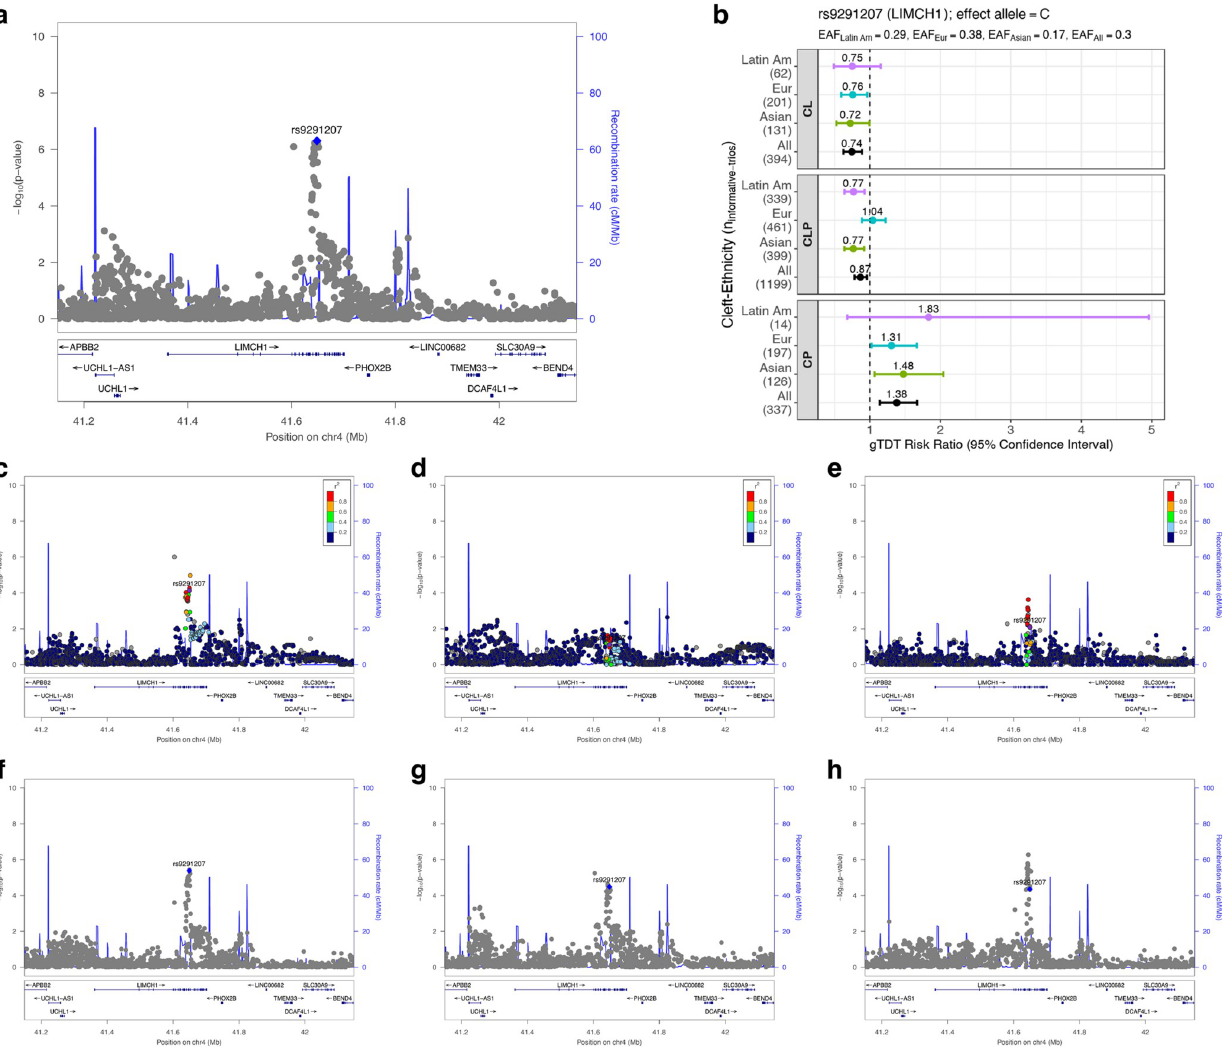
Fig 3. Regional association plots for 4p13 ( LIMCH1 ) identified as a region of genetic overlap between CL/P & CP. LocusZoom plots focus on PLACO analysis of ( a ) CL/P & CP (multi-ethnic), ( c ) CL/P & CP in Asian ancestry, ( d ) CL/P & CP in European ancestry, ( e ) CL/P & CP in Latin American ancestry, ( f ) CL & CP (multi-ethnic), ( g ) CLP & CP (multi-ethnic), ( h ) CL & CLP (multi-ethnic). The blue or purple diamond represents the most strongly associated SNP in the region showing evidence of genetic overlap. For stratified analyses across racial/ethnic groups, the colors of the SNPs represent their LD with the lead SNP (the most strongly associated SNP from panel a ), as shown in the color legend. For combined multi-ethnic analyses, there is no unique LD between SNPs and hence no color has been used. Panel b shows relative risk estimates of the lead SNP and their 95% confidence intervals as obtained from the gTDT